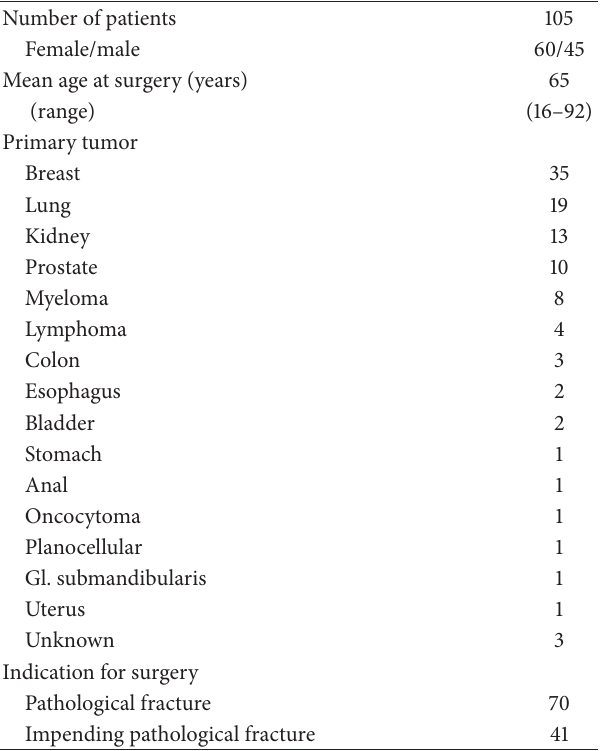
Table 1: Demographics and pathology of all consecutive patients treated with tumor resection and endoprosthetic reconstruction of the hip between 2010 and